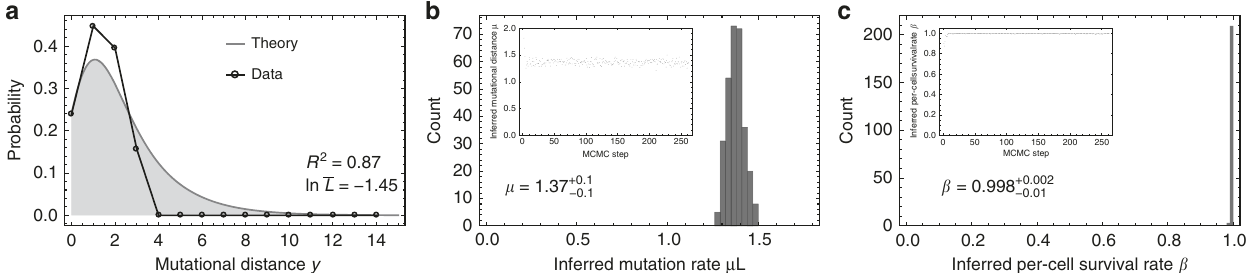
Fig. 4 Per-cell mutation and per-cell survival rate inferences in single neurons during development. a Mutational distance distribution inferred from 14 whole-genome sequenced single neurons from ref. 12 derived from one fetus (17 weeks past conception) (black dots), and best theoretical fi t (grey line). MCMC inference for b the mutation rate per cell division ( μ L ¼ 1 : 37 þ 0 : 1 (cid:2) mutations per genome per cell division) and c the per-cell survival rate 0 : 1 ( β ¼ 0 : 998 þ 0 : 002 (cid:2) ). Median point estimates and 95% credibility intervals were taken from the posterior parameter distributions. The inferred mutation rate 0 : 01 per cell division agrees with the original estimation of 1.3 mutations per cell division. Furthermore, our joined inference of mutation and cell survival rate con fi rms the original assumption of no cell death during early brain development.